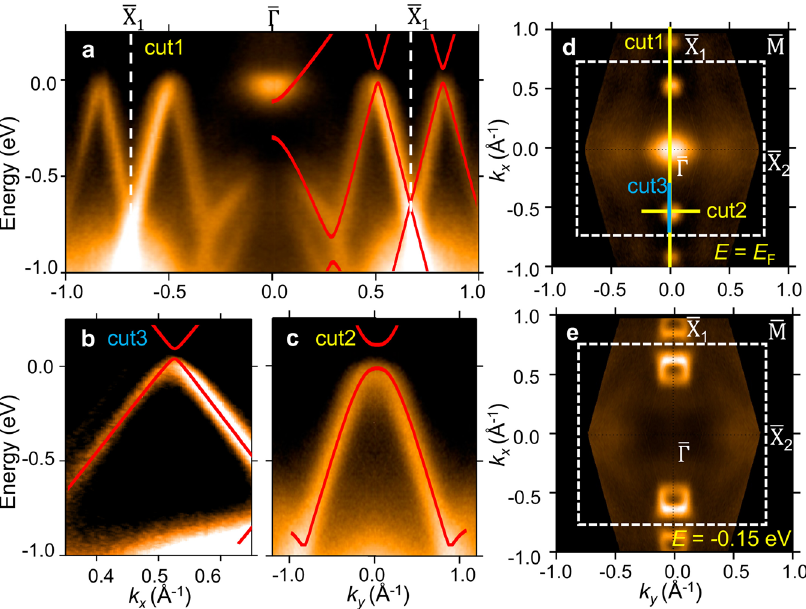
Fig. 3|ARPESspectrum of1L α -Sb.a ARPESspectrumtakenalong (cid:2) X 1 - (cid:2) Γ - (cid:2) X 1 . b , c Zoom-inspectratakenalong ‘ cut3 ’ and ‘ cut2 ’ (marked in d ),respectively. d Fermisurface taken from the 1L α -Sb sample by ARPES. e ARPES iso-energy contour taken at E = −